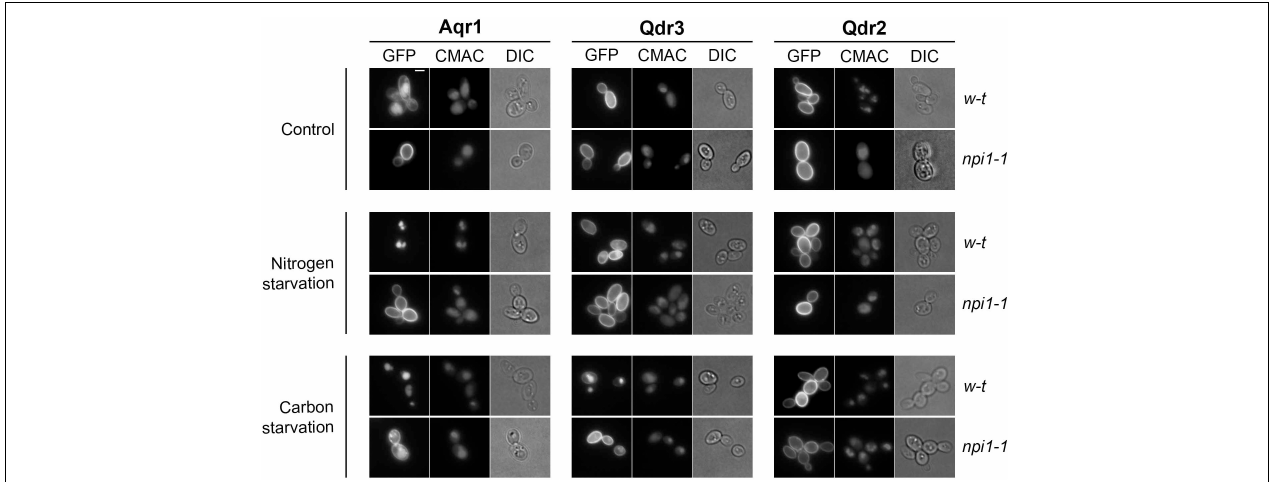
FIGURE 3 | Aqr1, Qdr2, and Qdr3 show distinct subcellular localization patterns under normal and starvation conditions. Cells of the wild-type strain and npi1-1 endocytosis mutant, expressing the hybrid gene AQR1-GFP, QDR3-GFP, or QDR2-GFP at the natural gene’s chromosomal locus from the GAL1-10 promoter, were initially grown overnight in minimal medium containing galactose (3%), glucose (0.3%), and glutamate. They were then collected, washed, and transferred to the same medium containing glucose (3%) and glutamate (Control), glucose (3%) but no glutamate (nitrogen starvation), or glutamate but no glucose (carbon starvation). After 90 min, the cells were observed by epifluorescence microscopy. CMAC dye was used to label the vacuolar lumen. Scale bar = 2 µ m.